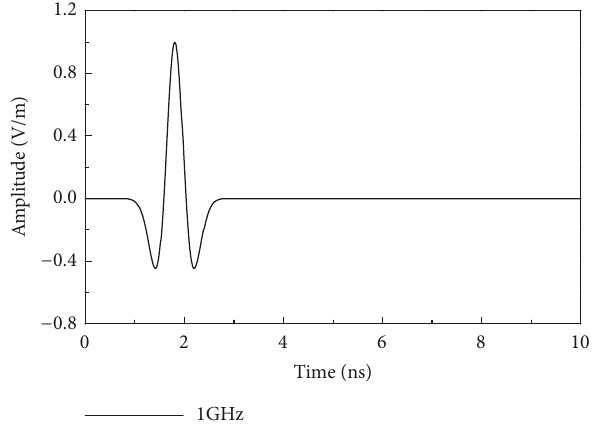
Figure 11: Map of Ricker waveform.